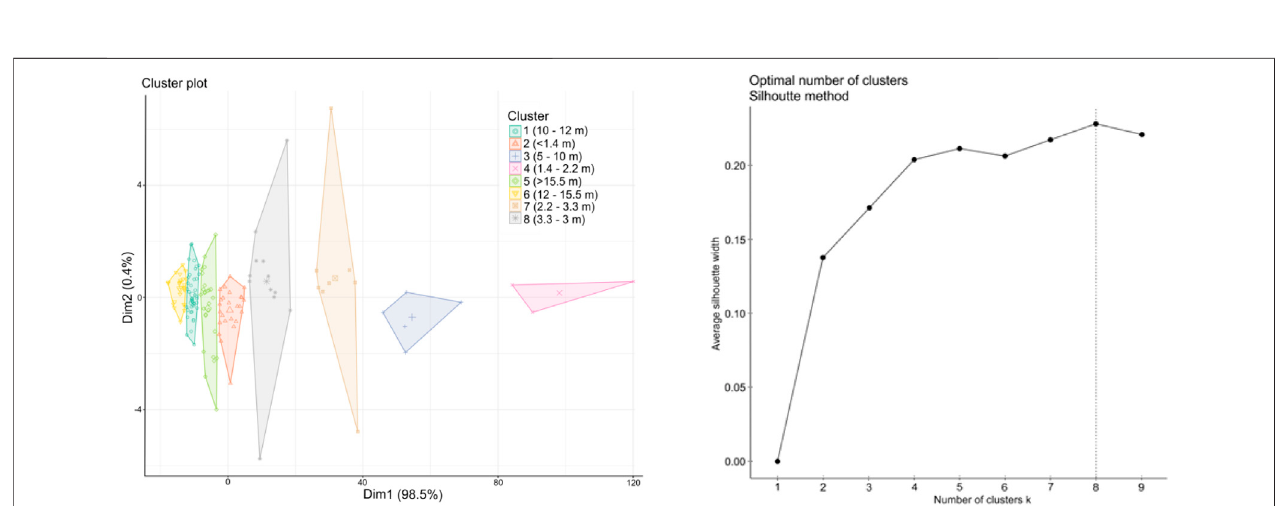
Frontiers in Environmental Science |